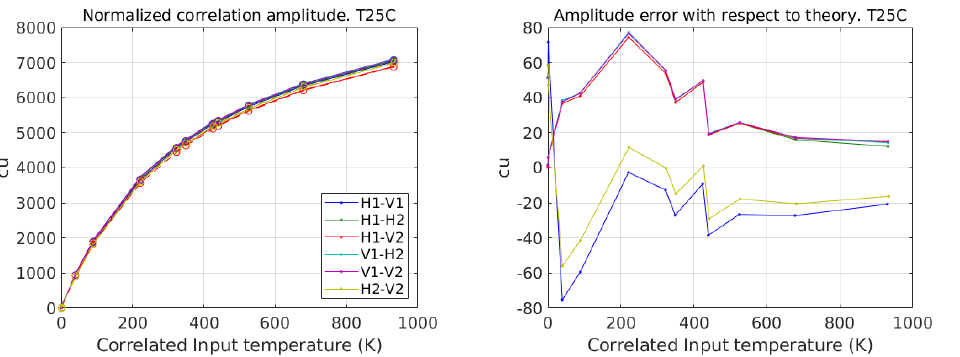
Figure 9. Left: Amplitude of the normalized correlation after correction and theoretical values in circles. The right plot shows the error with respect to the theoretical values. The legend of the left plot